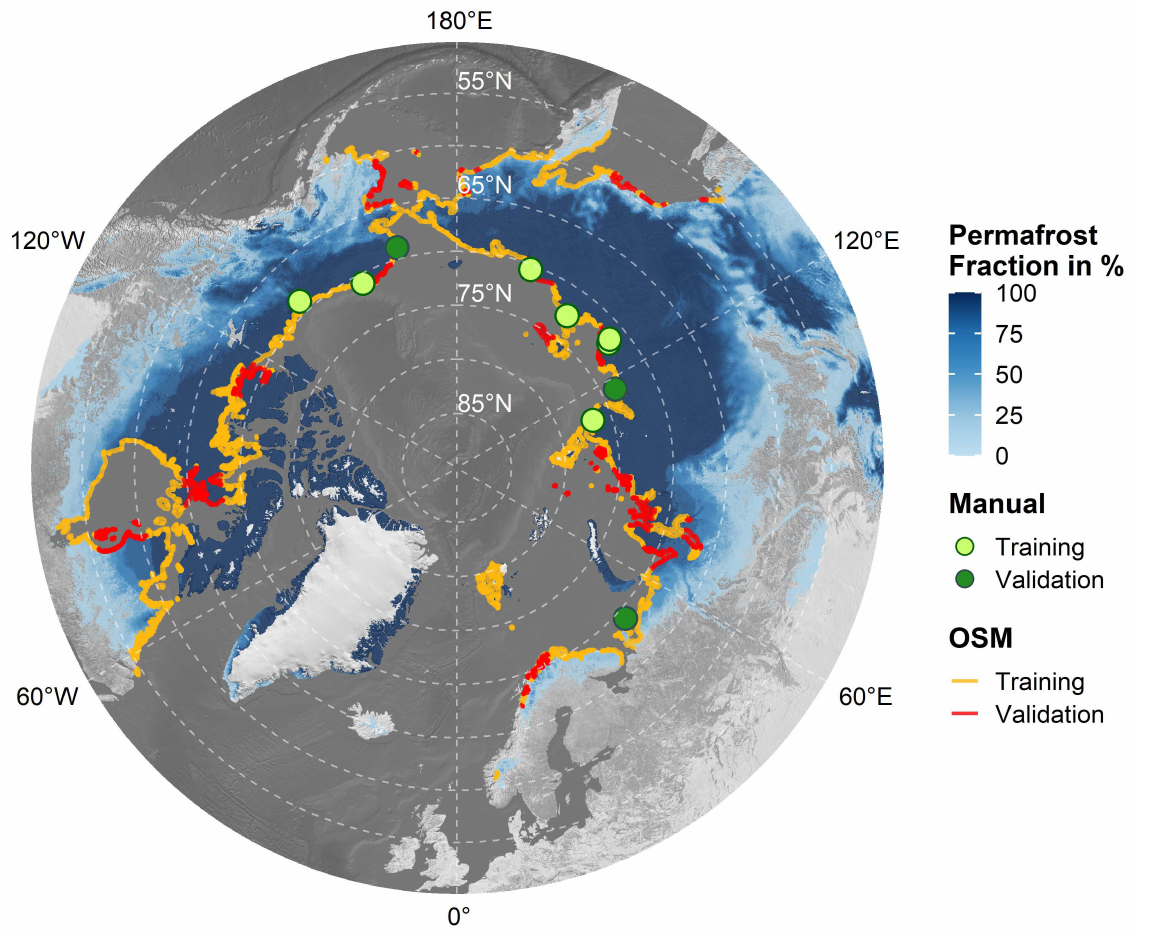
Figure 3. The study area divided into training and validation areas from the manually digitized sites (green points), as well as training and validation areas based on OpenStreetMap (OSM) (red and orange lines). The permafrost fraction across the Northern Hemisphere for the year 2017 based on data by Obu et al. [52] in combination with a shaded relief by Natural Earth [58] was utilized as a background map. All data is visualized in a polar Lambert azimuthal equal area